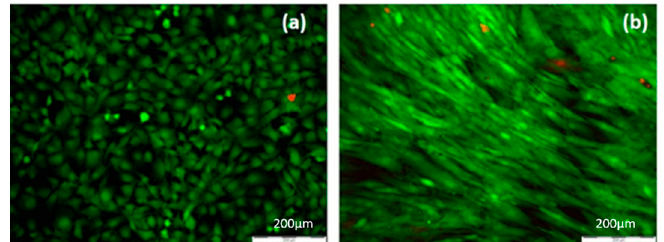
Figure 14. Fluorescence microscopy image of: ( a ) MC3T3 osteoblast cultured on non-treated surface for chitosan/ceramic composite film, ( b ) adipose derived stem cells (ADSC) cultured on control surface without laser treatment. Polymers 2018 , 10 , x FOR PEER REVIEW